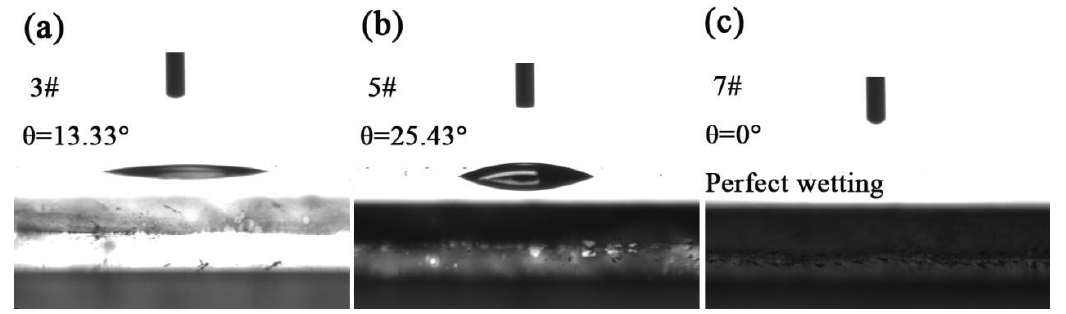
Figure 6. ( a ) Static contact angle of the ZnO nanorods (3#). ( b ) ZnO nanorods + Ag (5#). ( c ) ZnO nanorods + Ag + Ag 3 PO 4 (deposition three times 7#).